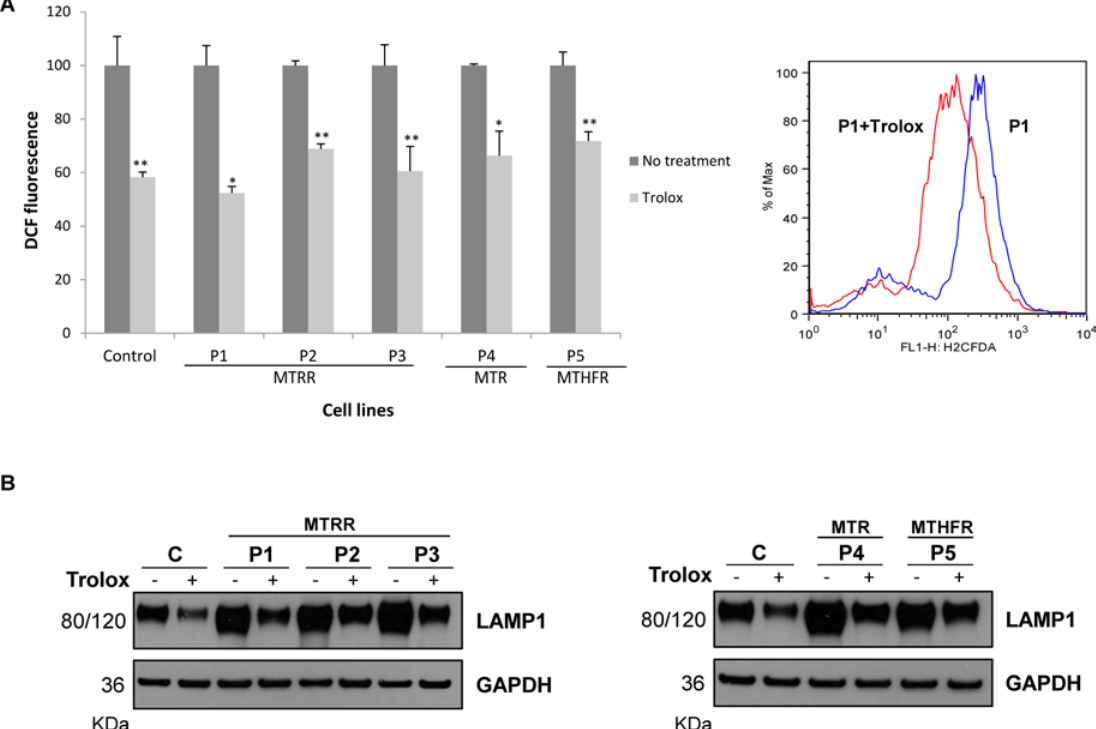
Fig 9. Analysis of trolox effect in ROS levels and autophagy marker´s levels in control and patients´ fibroblasts. (A) ROS content was determined by flow cytometry using H 2 DCFDA as fluorescence probe after cells were incubated for 72 h with 1 mM of trolox. Results are expressed as DCF fluorescence relative to untreated cells. Data represent mean values ± standard deviation from two experiments performed by triplicate ( * P < 0.05; ** P < 0.01). A representative overlap of ROS levels in untreated P1 cells and trolox-treated P1 fibroblasts is shown. (B) Cells were incubated with 1mM of trolox for 72 h. Equal amounts of protein from control and the five patients´ fibroblasts were loaded (50 μ g of total cell lysates) and subjected to immunoblotting with anti- LAMP1 antibody. We used anti-GAPDH antibody to ensure equal amounts of protein loaded in each lane. This result is representative of three independent experiments.